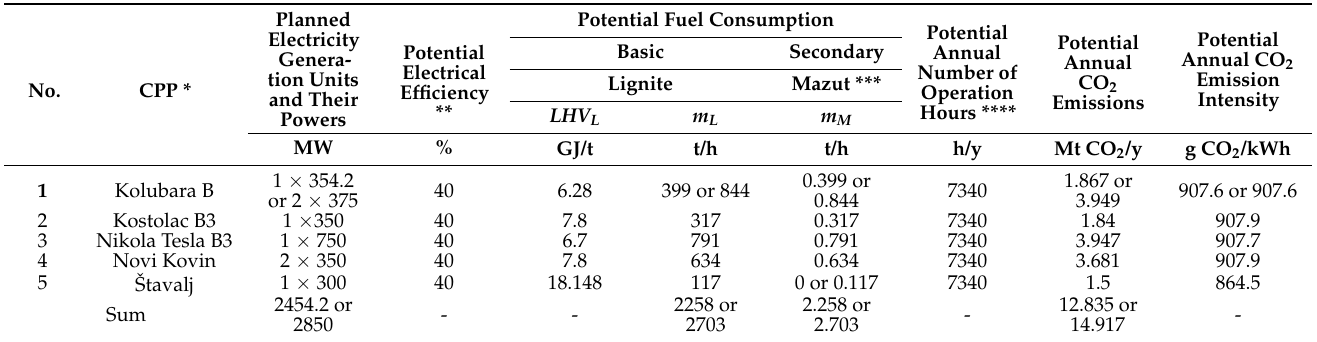
Table 2. An overview of the potential values of the performance indicators, annual CO 2 emissions, and annual CO 2 emission intensity for the planned CPPs in Serbia [78].